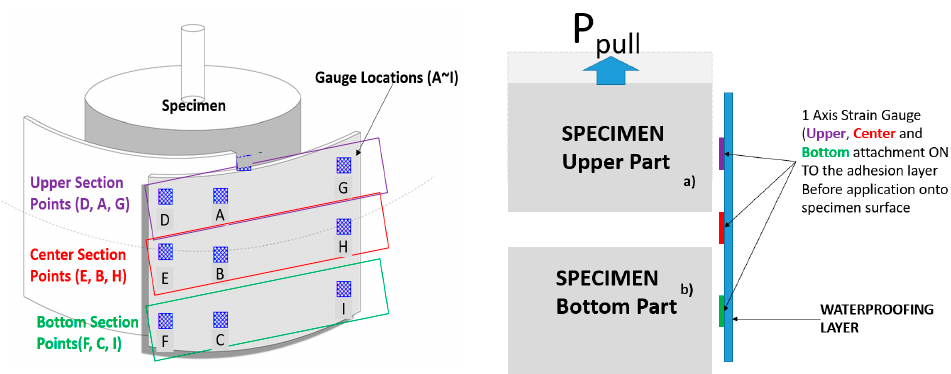
Figure 4. Strain gauge placement and measurement concept.